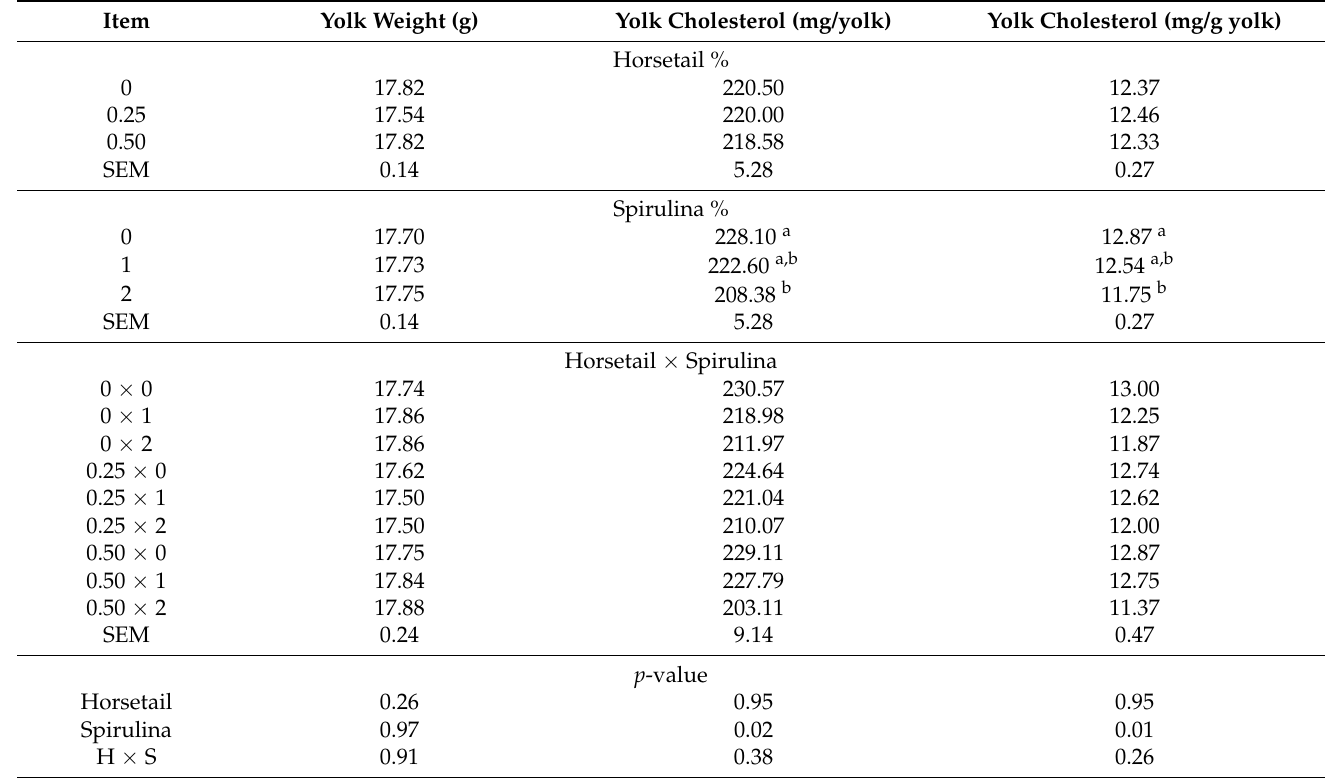
Table 6. Influence of treatments on egg yolk cholesterol and